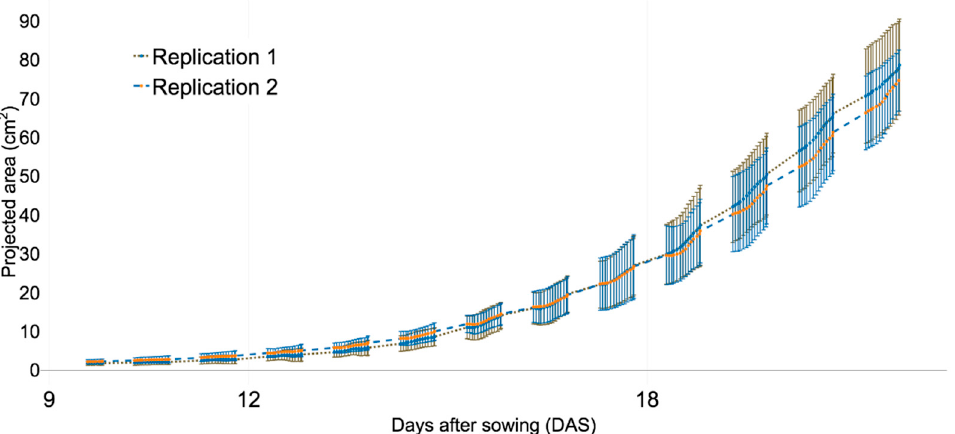
Figure 2. Comparing the growth pattern of the green lettuce cultivar between technical replications. Images were acquired between 07:00 to 20:00 in a 1-h interval. The results are presented as the mean of each time point from replication one ( n = 8) and replication two ( n = 8).